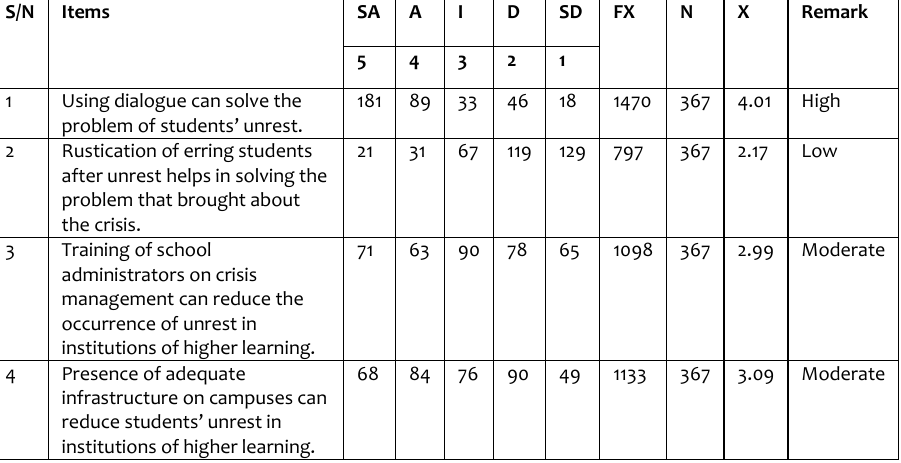
Table 8: Mean calculation of respondents based on measures that can be put in place to minimize the occurrence of students’ unrest in institutions of higher learning SA A I D SD S/N Items FX N 5 4 3 2 1